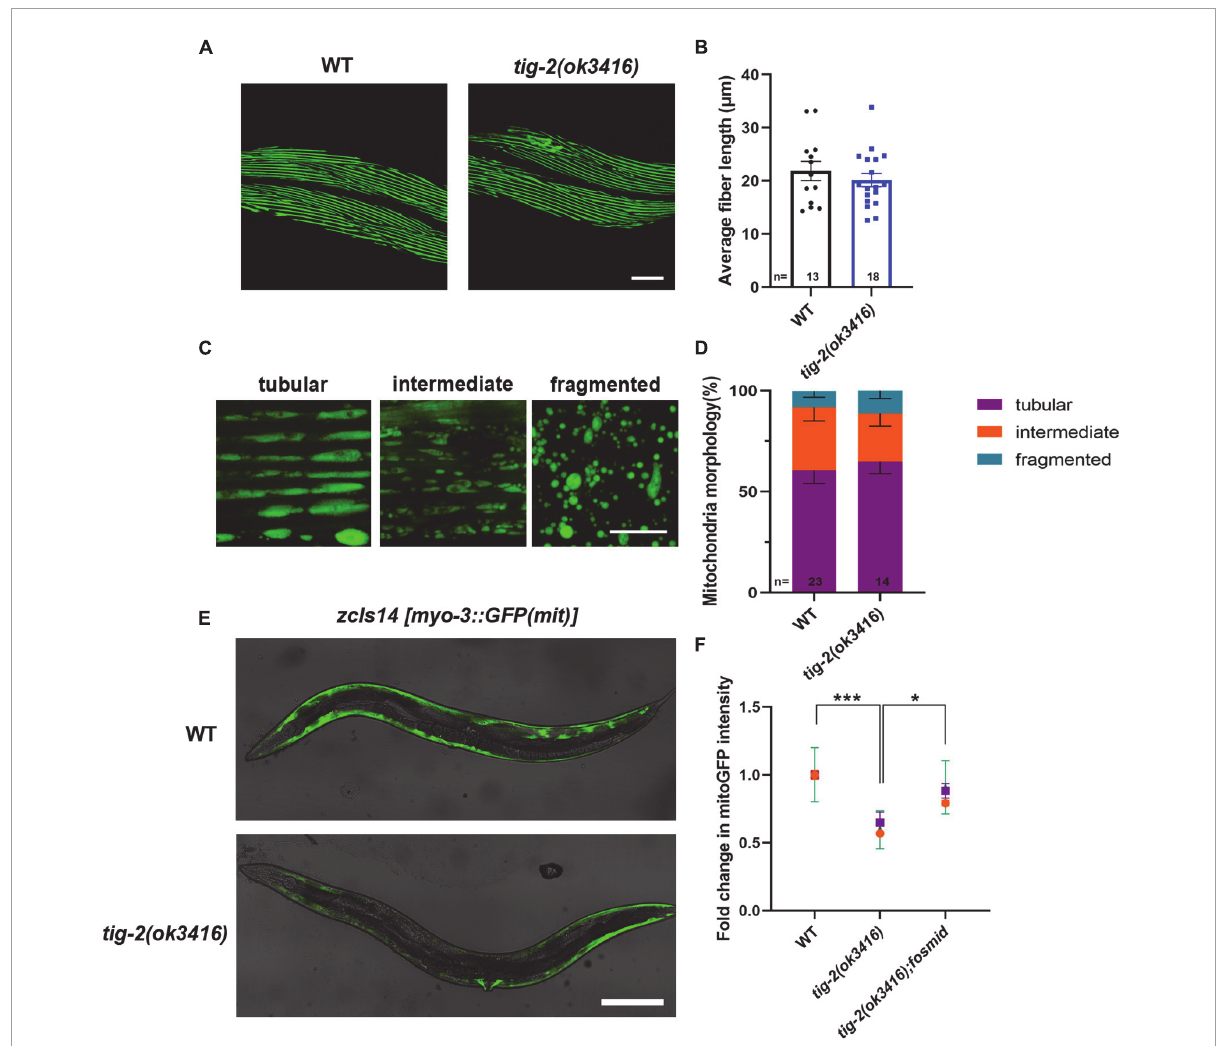
FIGURE5 tig-2 mutant has decreased mitochondrial content and mitochondrial calcium. (A) Images represent myosin fibers in body wall muscles. Scale bar is 20 µ m. (B) Quantification of average muscle fiber length of individual worms. tig-2 ( ok3416 ) mutants and wild-type worms exhibit similar muscle fiber morphology ( p = 0.4244). A student’s t -test was performed. (C) Representative images of mitochondria in body wall muscles showing three classes of cells. Scale bar is 5 µ m. (D) Quantification of three classes of muscle cells in wild-type worms and tig-2 ( ok3416 ) mutants. Data from day 3 adult worms suggested similar mitochondrial morphology in tig-2 mutants and wild-type worms. p -values were calculated by two-way ANOVA. (E) Representative images of mitochondria targeted green fluorescent protein (GFP) expressed in body wall muscles. Scale bar is 200 µ m. (F) Quantification of the intensity of mitoGFP in muscle cells. The intensity in tig-2 ( ok3416 ) is lower than in wild-type worms ( p = 0.0007), indicating fewer mitochondria content in tig-2 mutants. All data are normalized to wild-type worms. n = 3 technical replicates. p -values were calculated by two-way ANOVA. Error bars represent SEM. * p < 0.05, *** p <